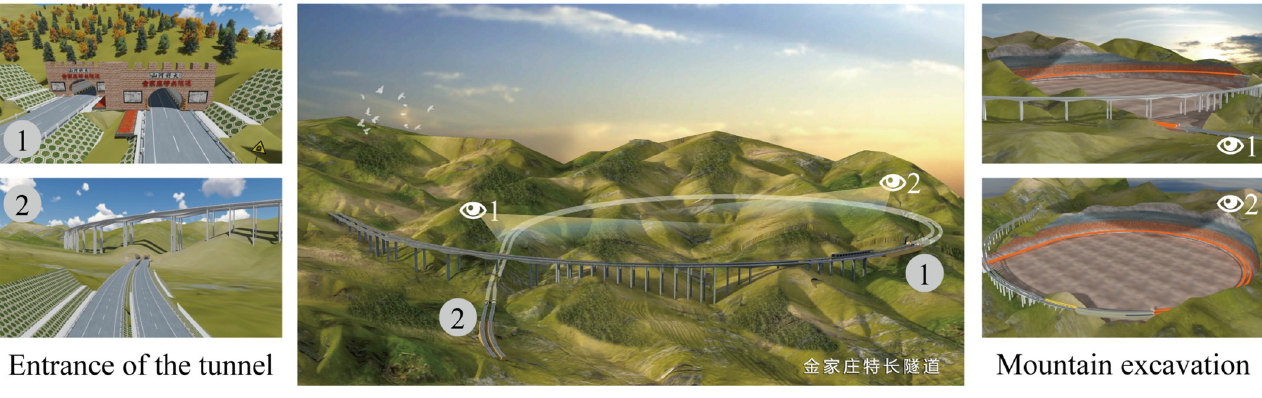
Fig 4. Jinjiazhuang Extra Long